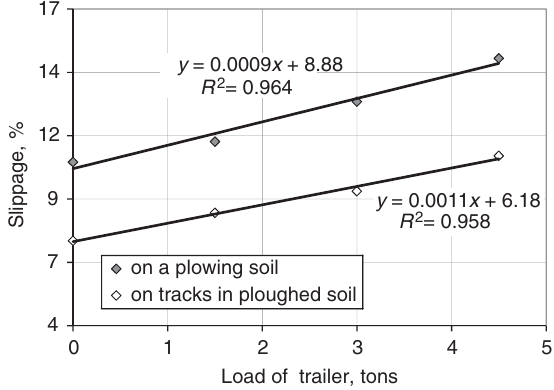
y = 0.0009 x + 8.88 R 2 = 0.964